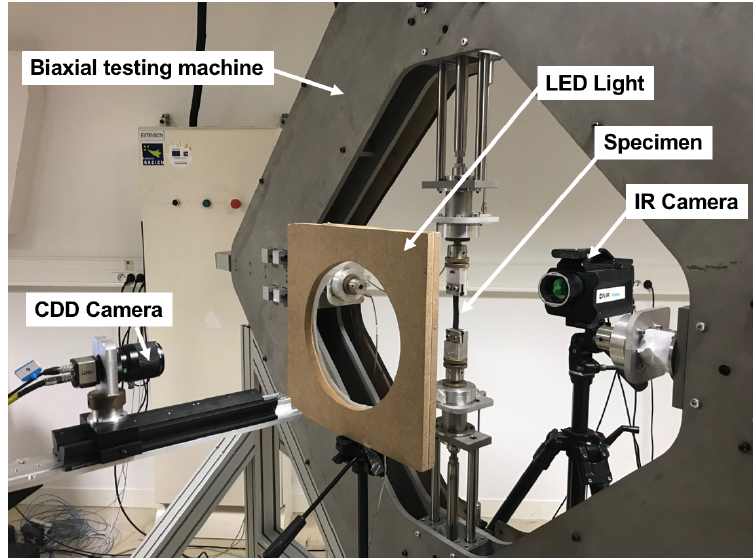
Figure 3. Photography of the experimental setup for mechanical characterization.